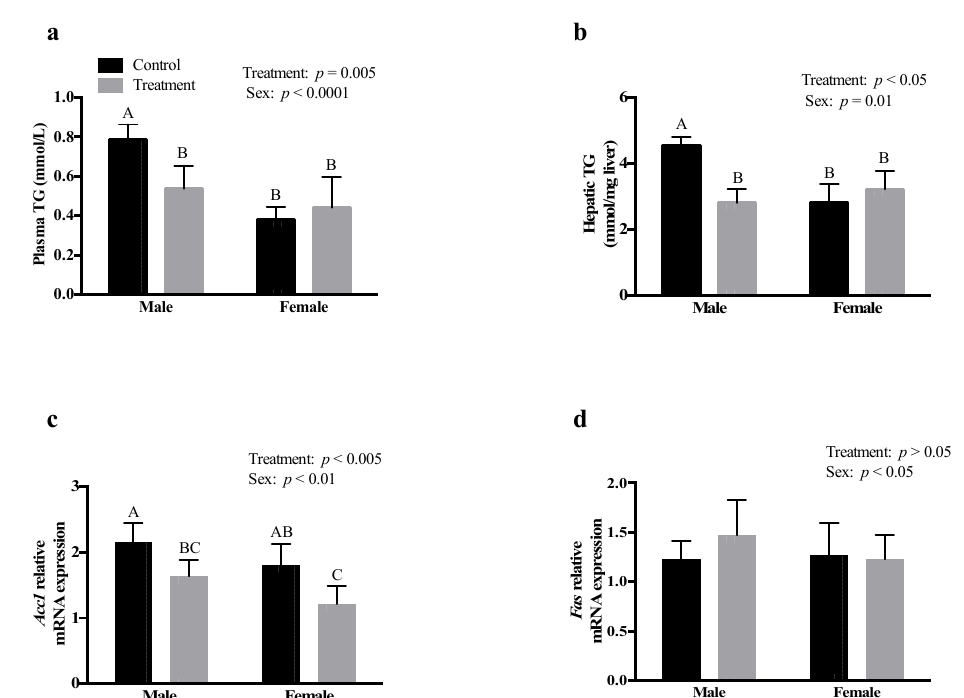
Figure 3. Intraperitoneal administration of an SCFA mixture had sex-specific effects on TG metabolism. Effect of SCFAs on, ( a ) plasma TG, ( b ) hepatic TG, and the relative mRNA expression of ( c ) Acc1 , and ( d ) Fas . Data were analyzed using two-way ANOVA followed by Tukey’s post hoc test. The mRNA expression data are presented relative to β -actin. All data are expressed as mean ± SD. Different superscripts indicate significant difference among groups; p < 0.05 was considered significant ( n = 6). Acc1— acetyl-CoA carboxylase subform1, Fas —fatty acid synthase, SCFAs—short-chain fatty acids,